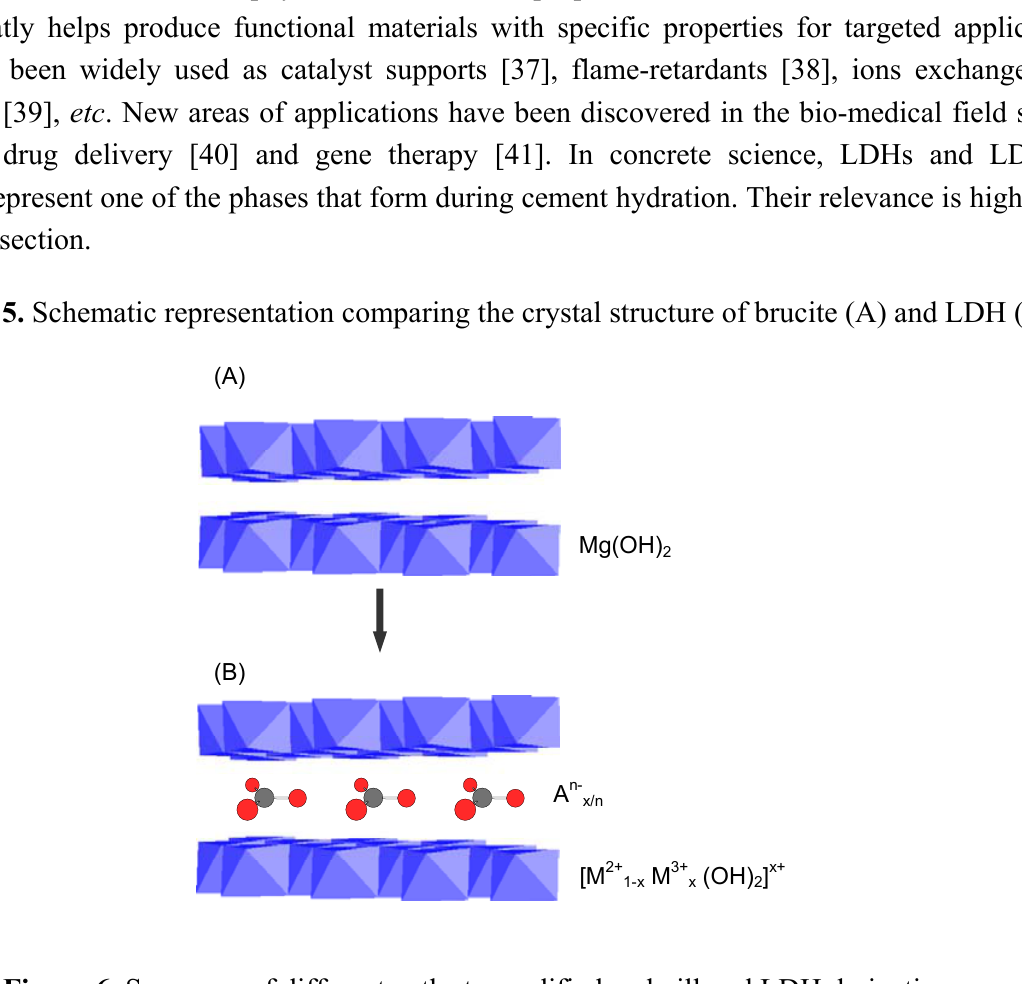
Figure 6. Summary of different paths to modified and pillared LDH